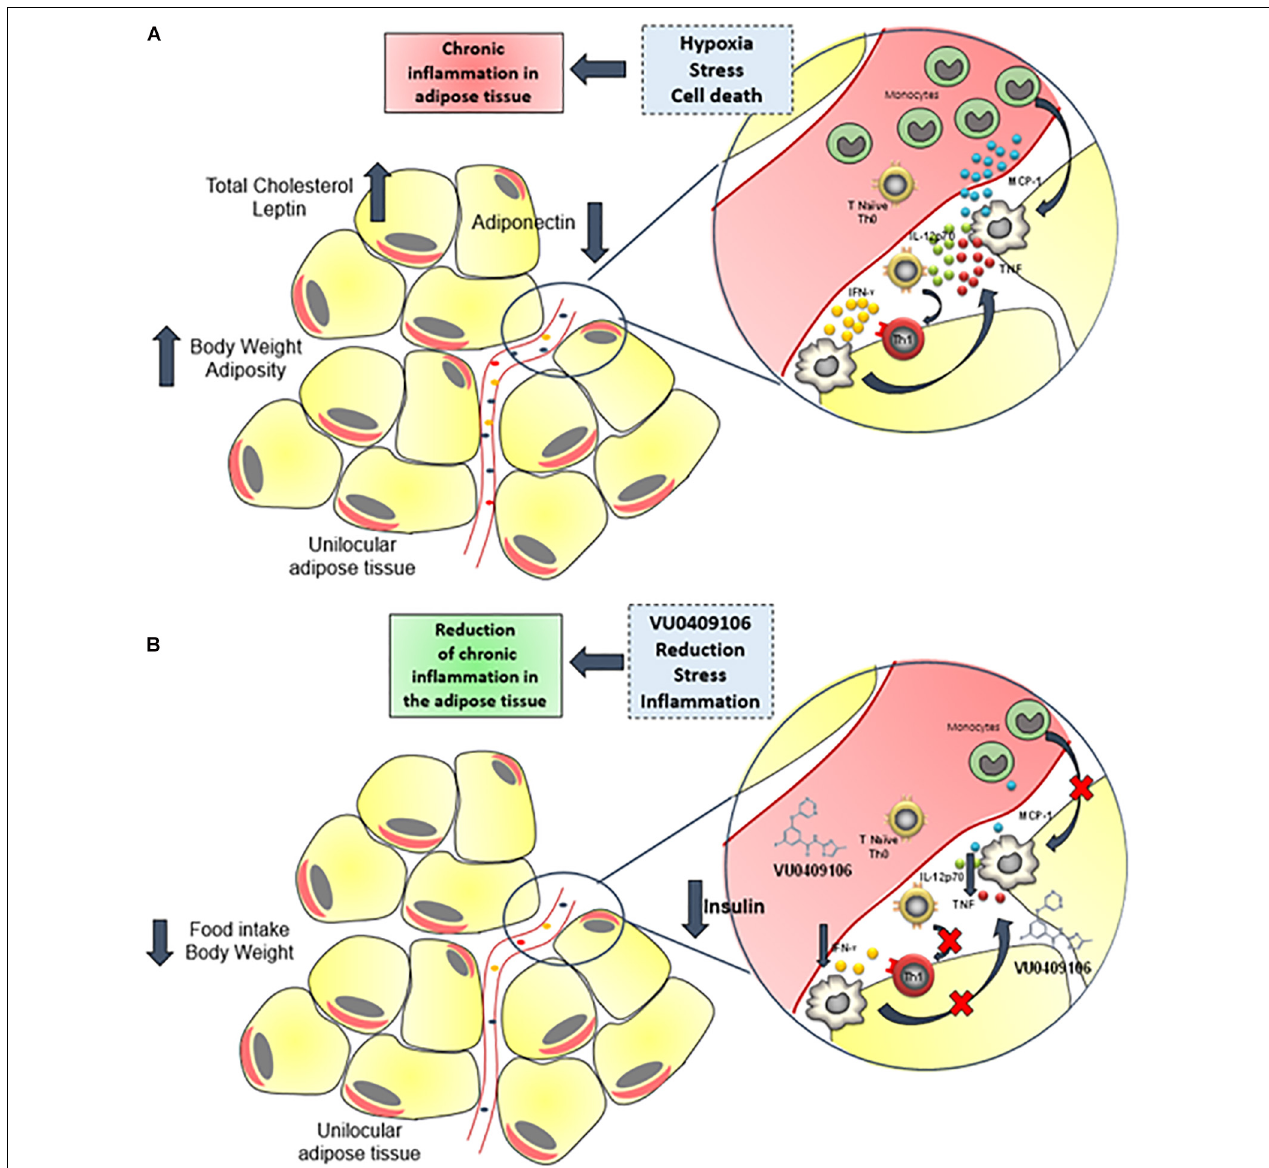
FIGURE 6 | Anti-inflammatory role of VU0409106 in the adipose tissue of obese mice. (A) Increased adiposity may contribute to hypoxia, stress, and cell death, which triggers an inflammatory response with enhanced local levels of inflammatory mediators, especially cytokines such as IL-12p70, TNF- α , and IFN- γ and the chemokine MCP-1 and consequent immune cell recruitment. As a result, a chronic, low-grade inflammation of adipose tissue is sustained. (B) Chronic administration of VU04090106 reduces food consumption and body weight and promotes an anti-inflammatory